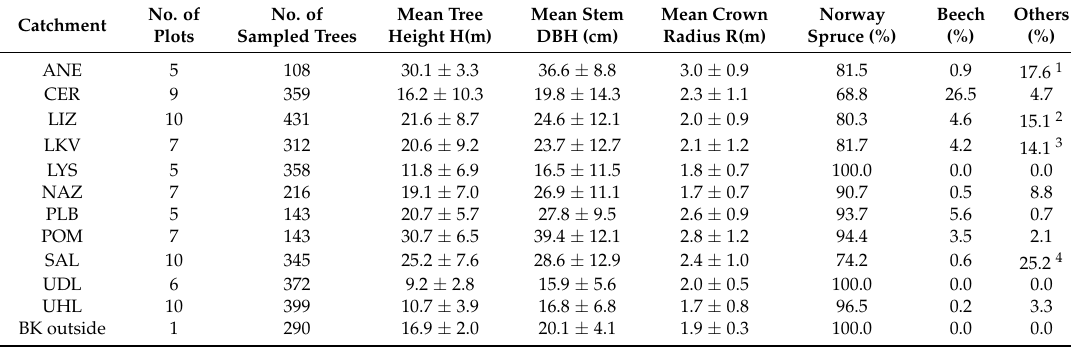
Table 2. Forest characteristics per stream catchment as measured in field surveys during 2015–2016. Mean values are presented together with standard deviation. Last row reports characteristics measured at the Bílý Kˇríž site in